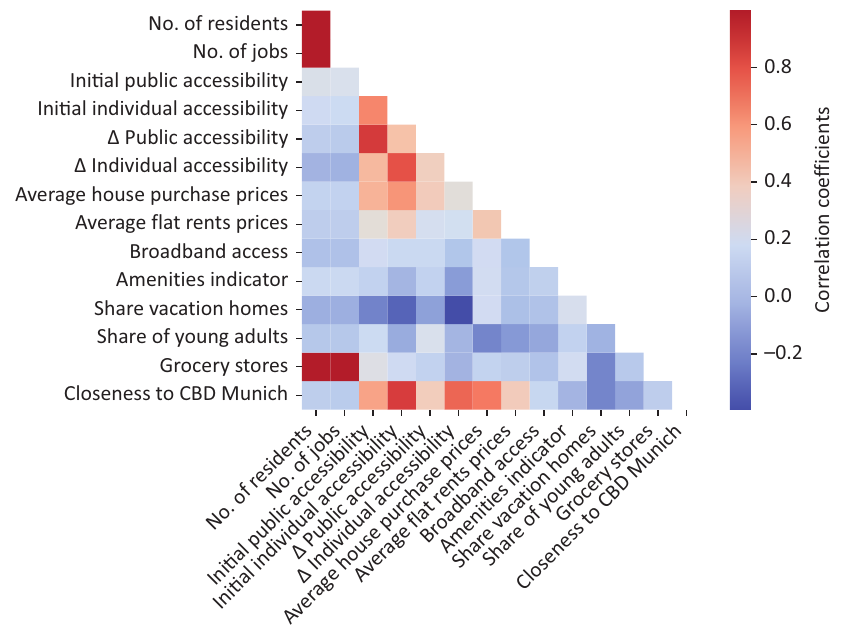
Figure 2. Correlation heat map between sub‐indicators related to the WFH index. Note: Low correlation values are red and high correlation values are